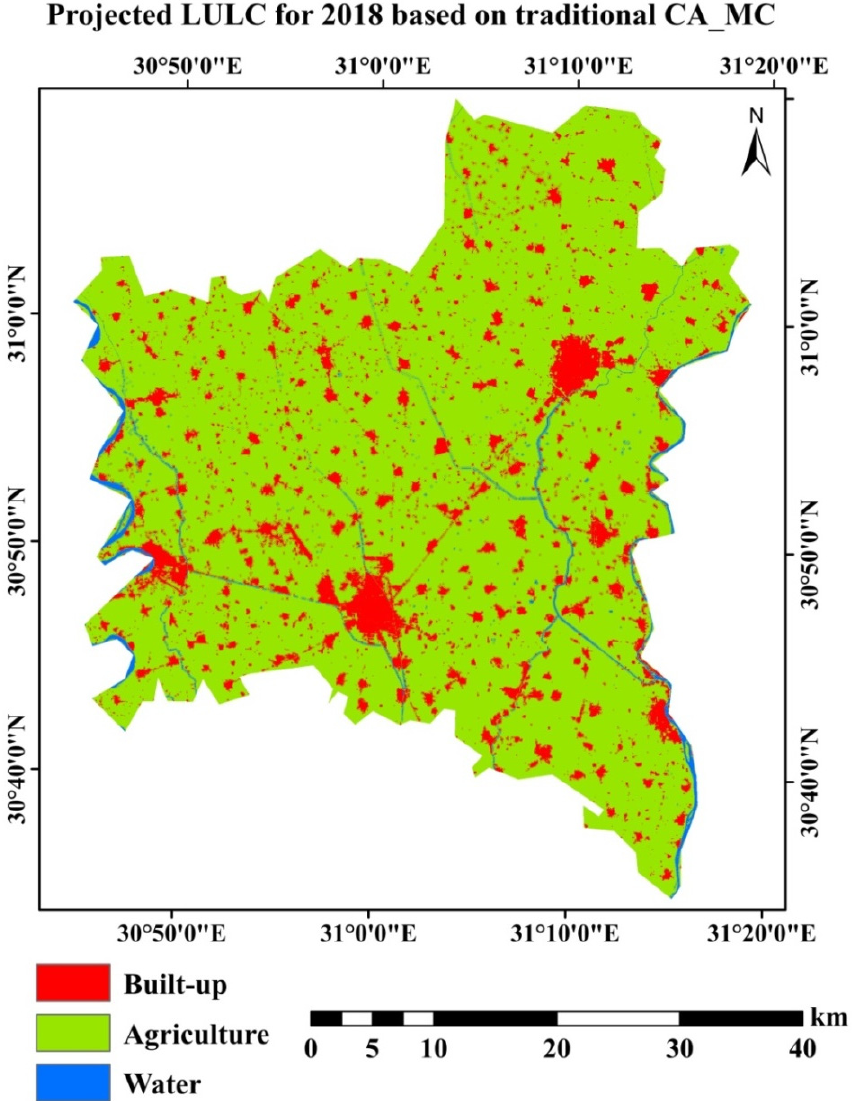
Figure 4. The simulated LULC for 2018 obtained based on the traditional CA-Markov model .